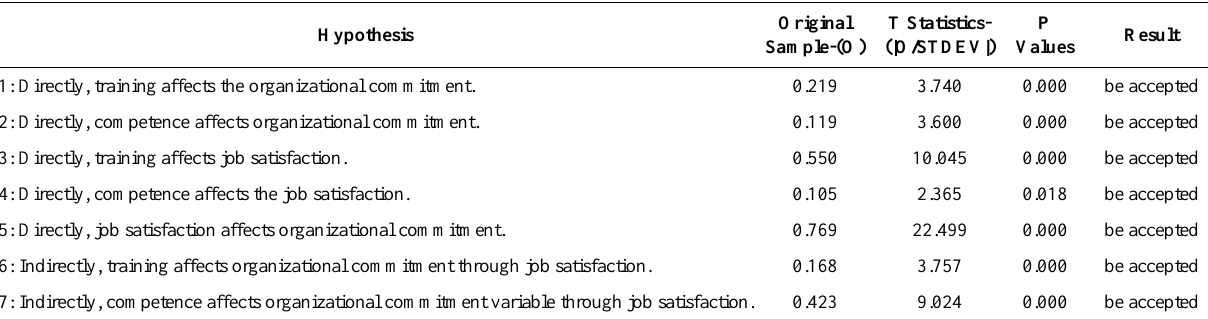
Table 4. Hypotheses Test